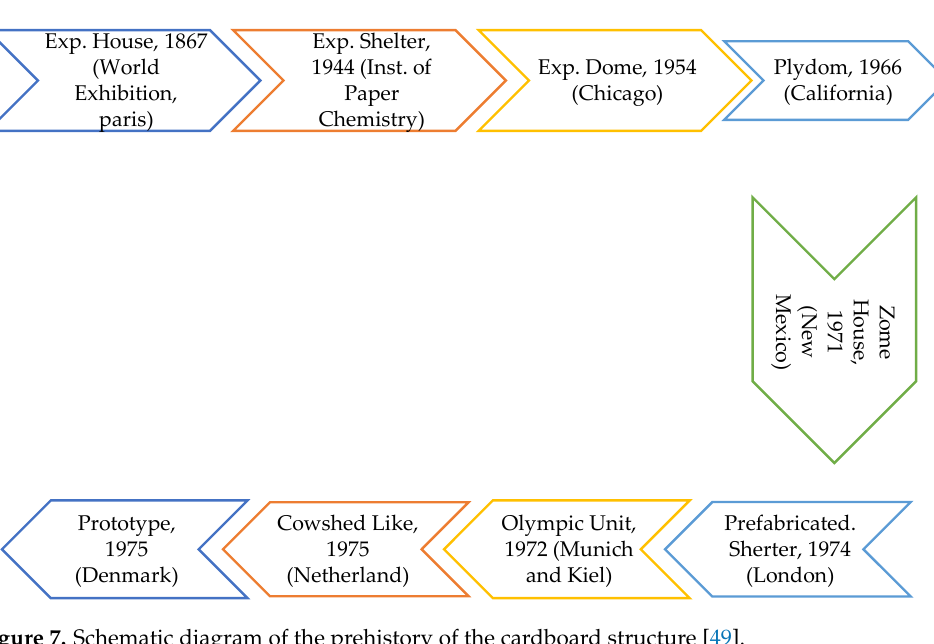
Figure 7. Schematic diagram of the prehistory of the cardboard structure Fgure 7. Schematic diagram of the prehistory of the cardboard structure [49]. During the initial period, cardboard was essentially used as panels or walls. All the structures were temporary construction, and coating with polyethene was the usual pro- cedure to protect them from the weather. However, few experiments were carried out with paint (Exp. Shelter, 1944, by the Institute of Paper Chemistry, Appleton, Wisconsin, USA), fibreglass (prefabricated Olympic Unit, 1972) and aluminium lamination (Baer Zome house, 1971, Corrales, New Mexico). The stapling connection was common during the above period, and adhesive tapes were used to seal the cut edges (Cowshed Like, 1975, Netherland) [49]. These temporary structures mainly suffered from humidity and could